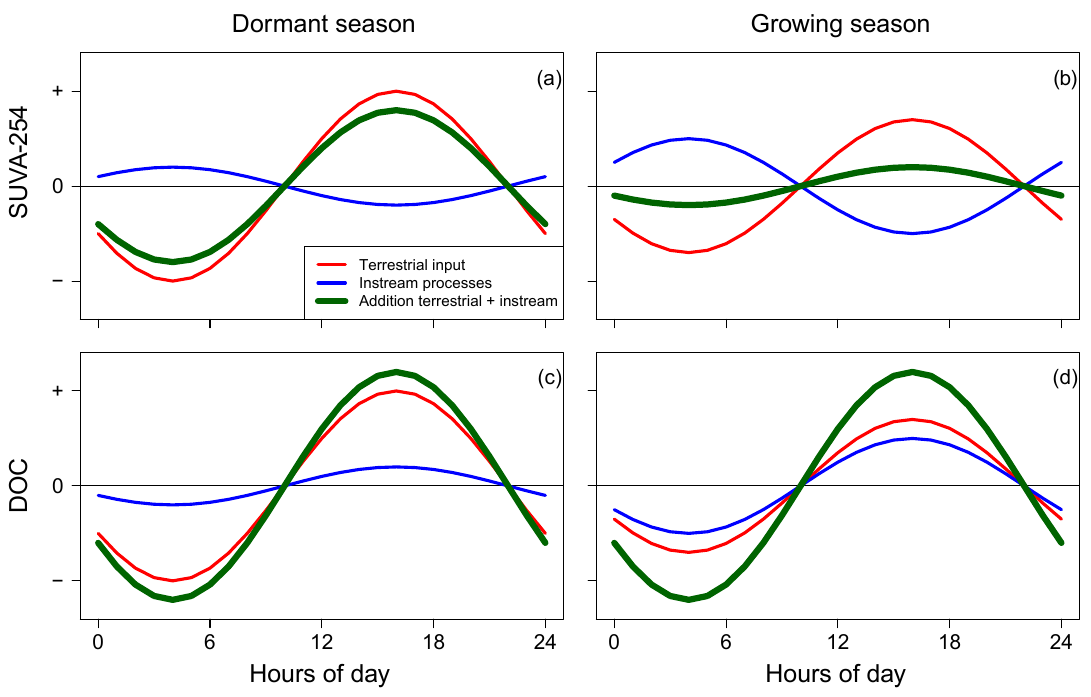
Figure 7. Perceptual understanding of the diel SUVA-254 and DOC fluctuations and their dependence on instream processes or terrestrial input and the resulting superposition of both